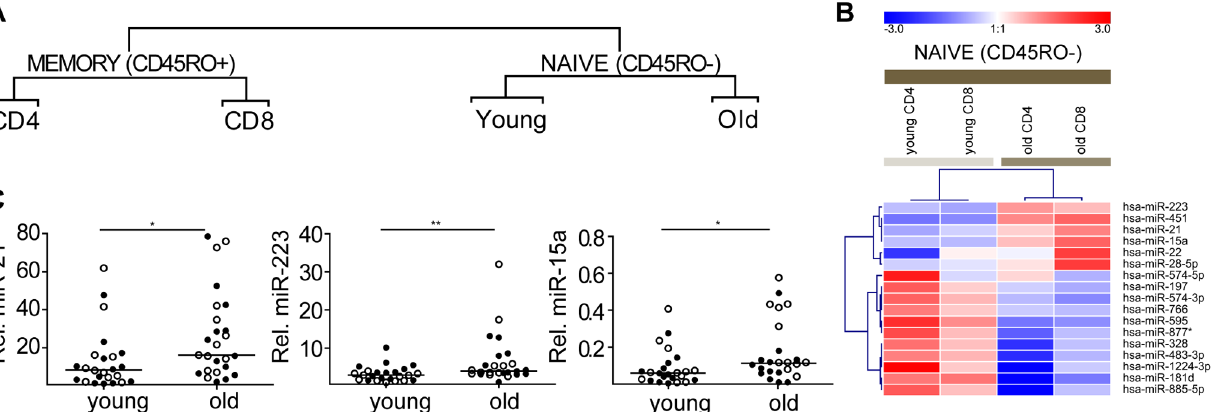
Fig 1. Age-related differences in miRNA expression are predominantly found in CD45RO- T cells. (A) Unsupervised hierarchical cluster analysis of 166 miRNAs revealed a clear distinction between CD45RO- and CD45RO+ T cells. Within the CD45RO- subgroup the next separation was based on age, whereas in CD45RO+ T cells the next clustering was based on expression of CD4/CD8 (the complete heatmap can be seen in Figure C in S1 File). (B) Heatmap of miRNAs differentially expressed in young versus old CD45RO- T cells (n = 17) using a 2-fold expression change cut-off ( (cid:3) 2 fold) between young and old CD45RO- T cells. The blue to red gradient on the heatmap indicates relative miRNA expression levels varying from low (blue) to high (red). (C) Relative expression levels in CD45RO- T cells as determined by qRT-PCR of miR-21, miR-223 and miR-15a in CD45RO- T cells from young and old donors. MiRNA expression levels were normalized to the expression levels of RNU49 (lines indicates median). Filled circles indicate CD4 T cells and open circles indicate CD8 T cells, * p (cid:1) 0.05, ** p (cid:1)